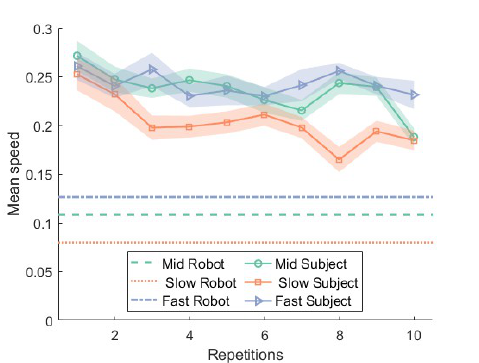
Figure 10: Individual subjects’ speed in the “Robot Fast” speed condition, displayed in relation to the corresponding speed in the “Robot Slow” speed condition (in the “One Box” condition) for both countries. The bigger circles with error bars represent the mean and standard error. If a subject had the exact same speed in the two conditions, the respective marker would be on the dashed